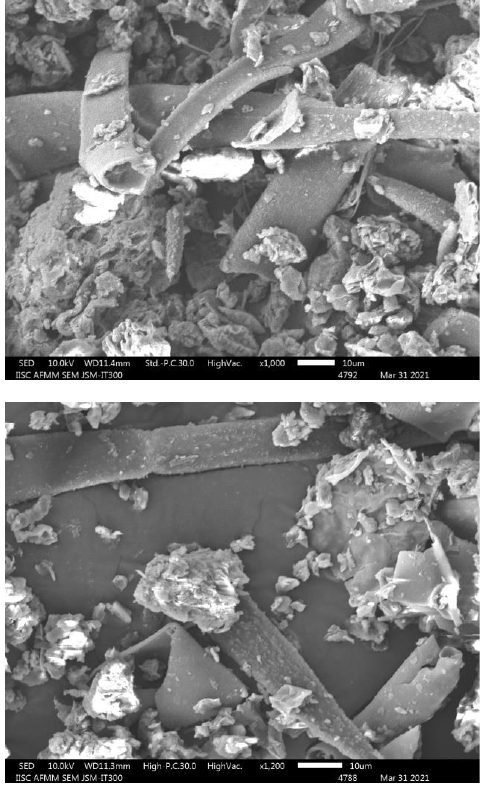
Figure 5. SEM images of MGP observed at 1000x (top) and 2500x (bottom) magnification